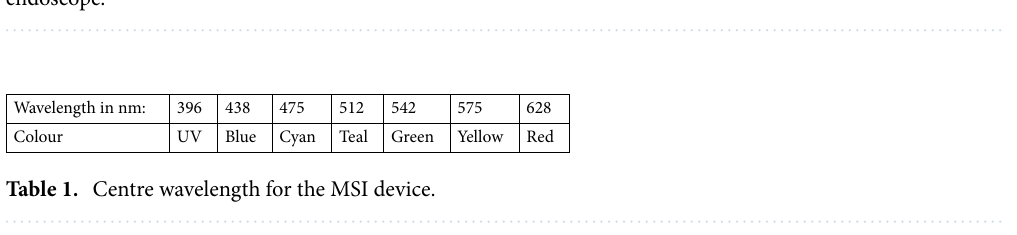
Figure 1. Schematics of the set-up (modified as described in our previous study 18 ). The top schematic shows the overall set-up and the bottom schematic shows the optical set-up which images the light from the endoscope.